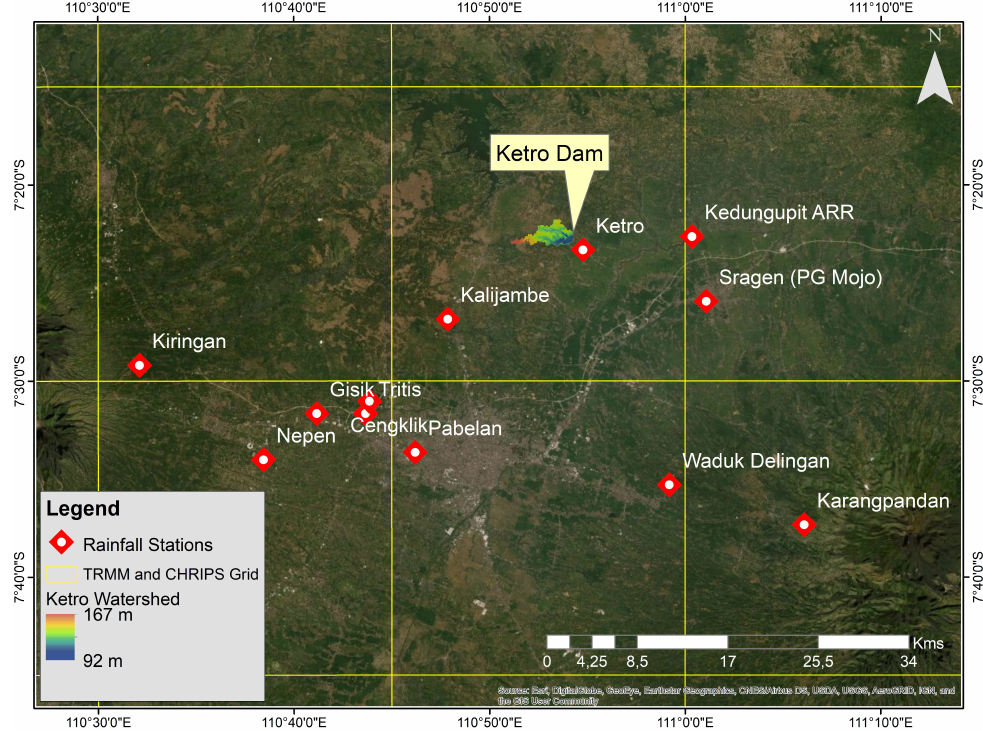
Figure 3. Position of ground station data, TRMM, and CHIRPS grids with respect to the catchment